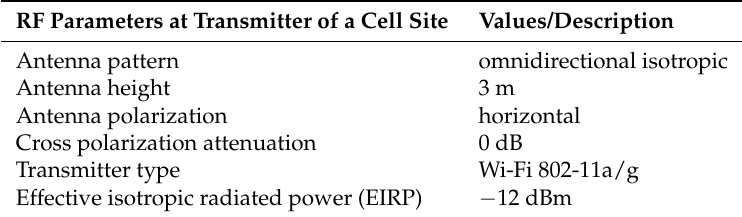
Table 1. Simulation parameters for wireless indoor